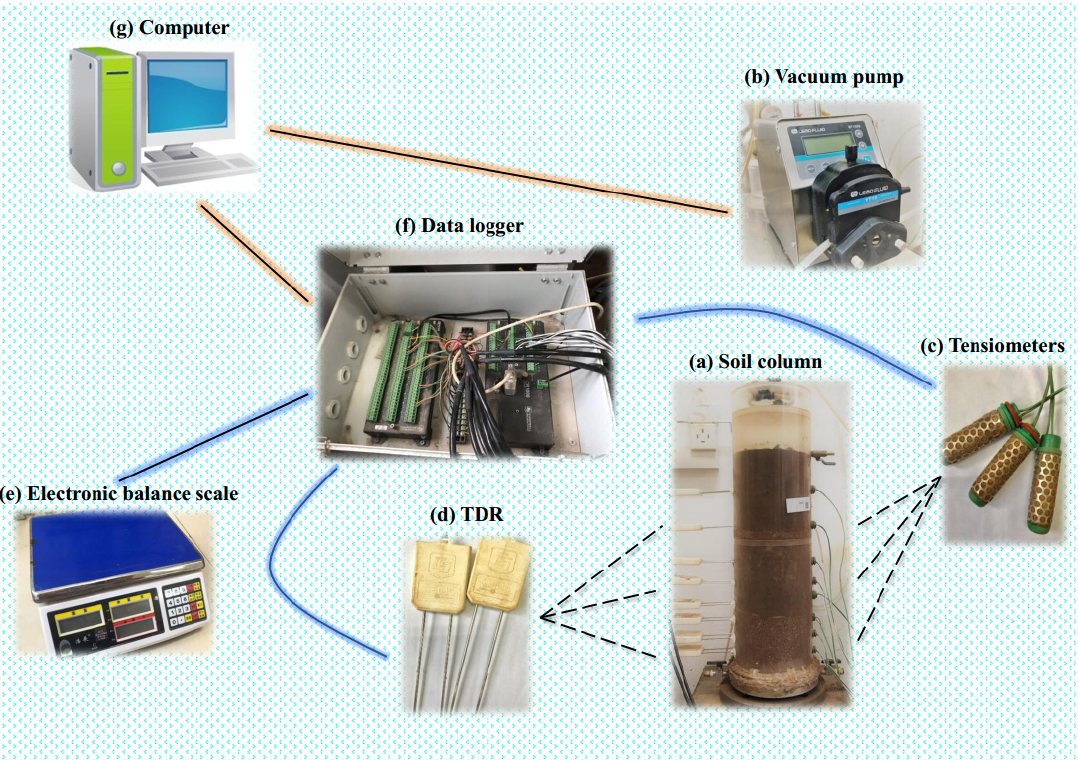
Figure 5. Measuring devices and data logger system: ( a ) Soil column, ( b ) Vacuum pump, ( c ) Tensiometers, ( d ) Time-domain reflectometry TDR, ( e ) Electronic balance scale, ( f ) Data logger, ( g ) Computer.